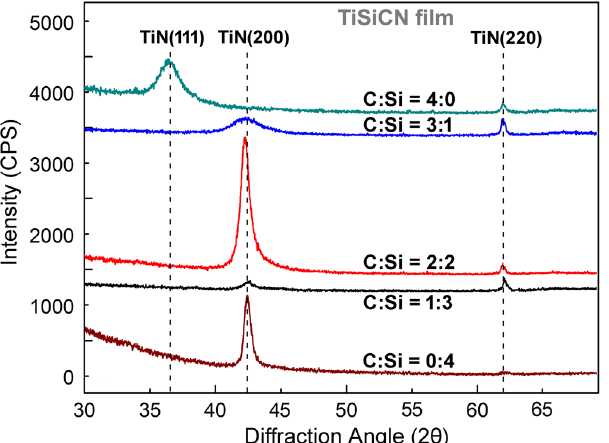
Figure 2. XRD patterns of the TiSiCN nanocomposite films with the different C/Si content ratios. The diffraction peaks refer to the face-centered cubic structured TiN phase. No other diffraction peaks from crystalline phases can be detected. The TiSiCN film with the C/Si content ratio of 2:2 presents the highest diffraction peak